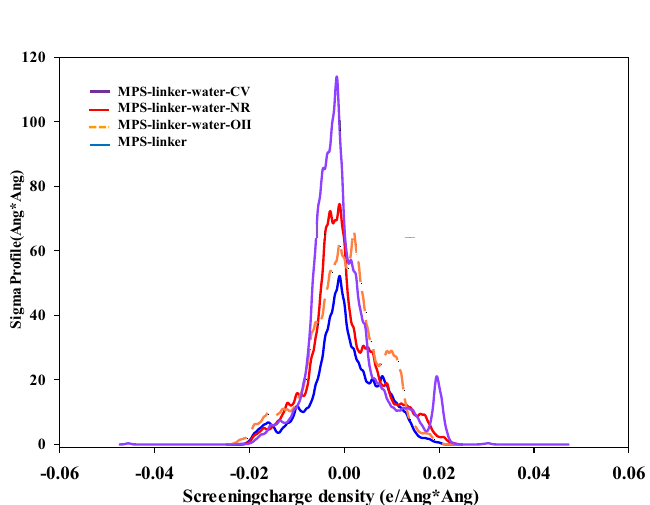
-0.06 Screeningcharge density (e/Ang*Ang) Figure 6. The obtained Sigma profile for MPS-linker-water-NR, MPS-linker-water-CV, MPS-linker-water-OII and